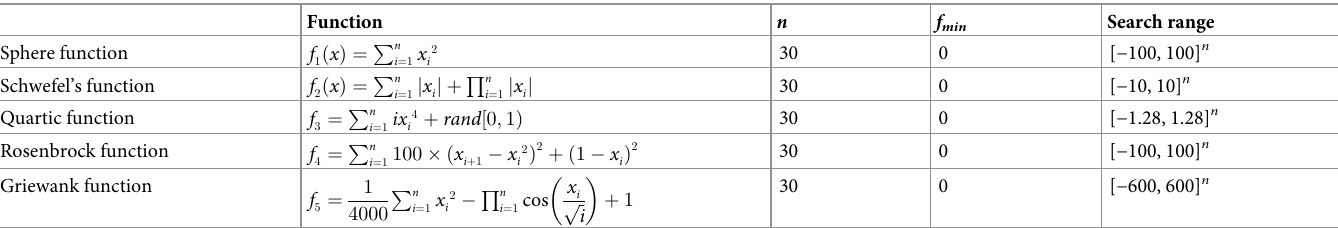
Table 1. Benchmark functions used in this study.